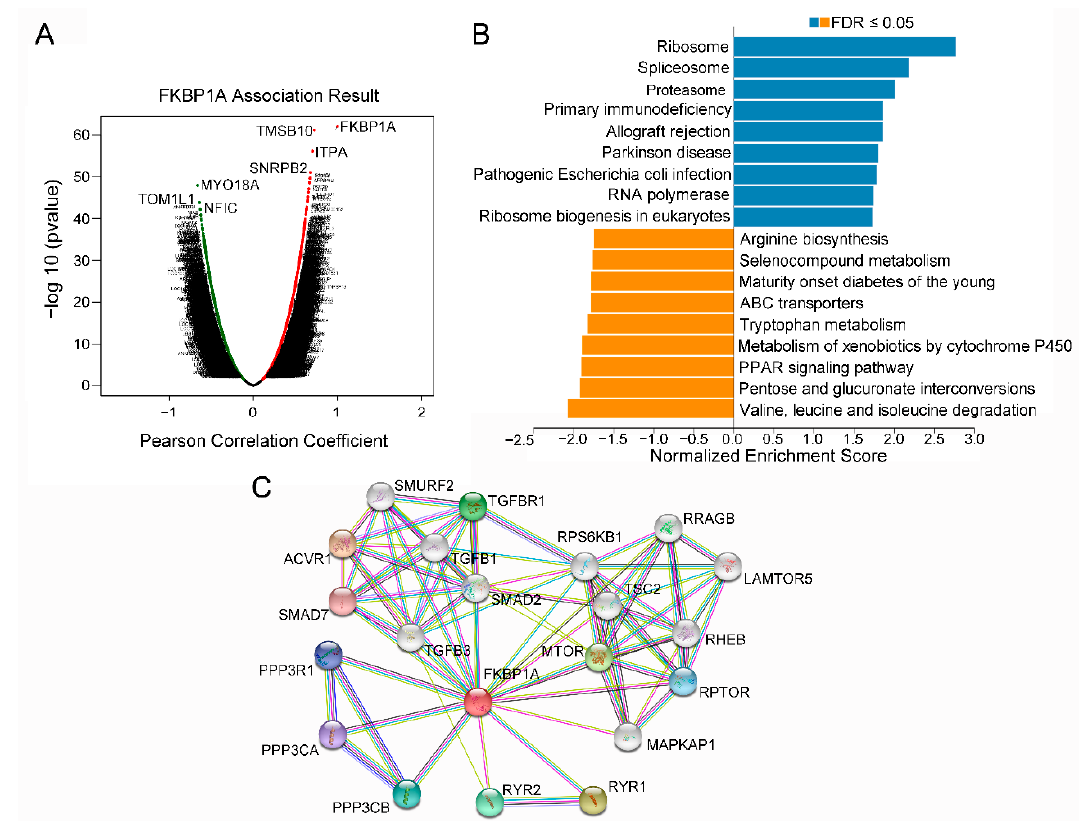
Figure 7. The co-expression genes with FKBP1A and function of enrichment analysis concerning FKBP1A -related genes in LIHC. ( A ) All the genes significantly associated with FKBP1A distinguished by Pearson test in LIHC cohort (LinkedOmics database). Red and green dots represent positively and negatively significantly correlated genes with FKBP1A , respectively. ( B ) KEGG pathway analysis. Dark blue and orange indicate FDR ≤ 0.05. FDR, false discovery rate. ( C ) A protein–protein interaction (PPI) network of FKBP1A protein from STRING database.